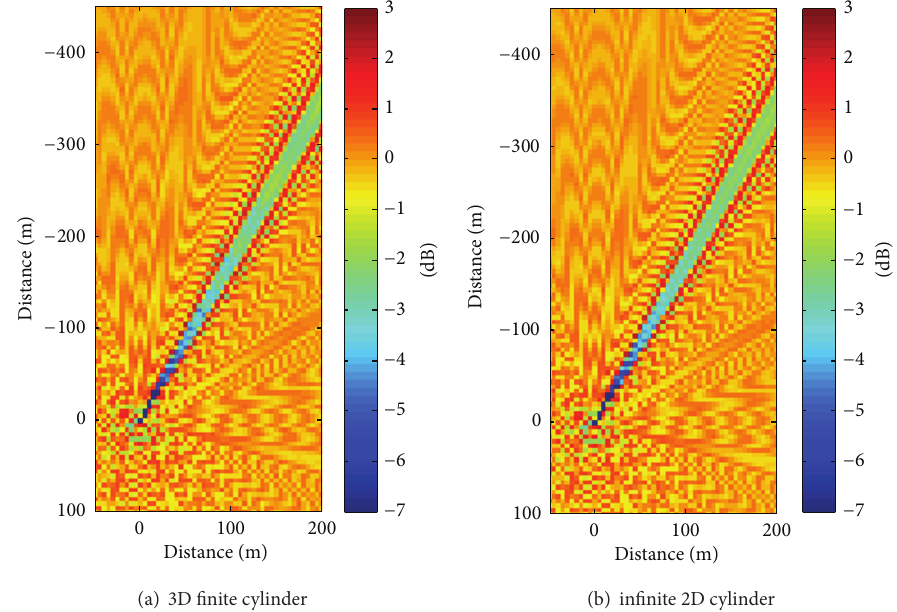
Figure 3: Results of the single-turbine simulation at 500MHz. (a) Near-field distribution around a 3D finite cylinder. (b) Near-field distribution around an infinite 2D